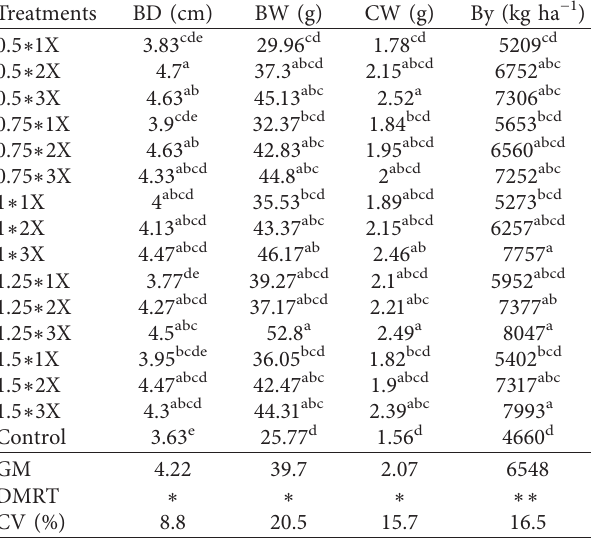
Table 4: The mean of garlic bulb yield and yield component data at Kabe in 2019 cropping season.